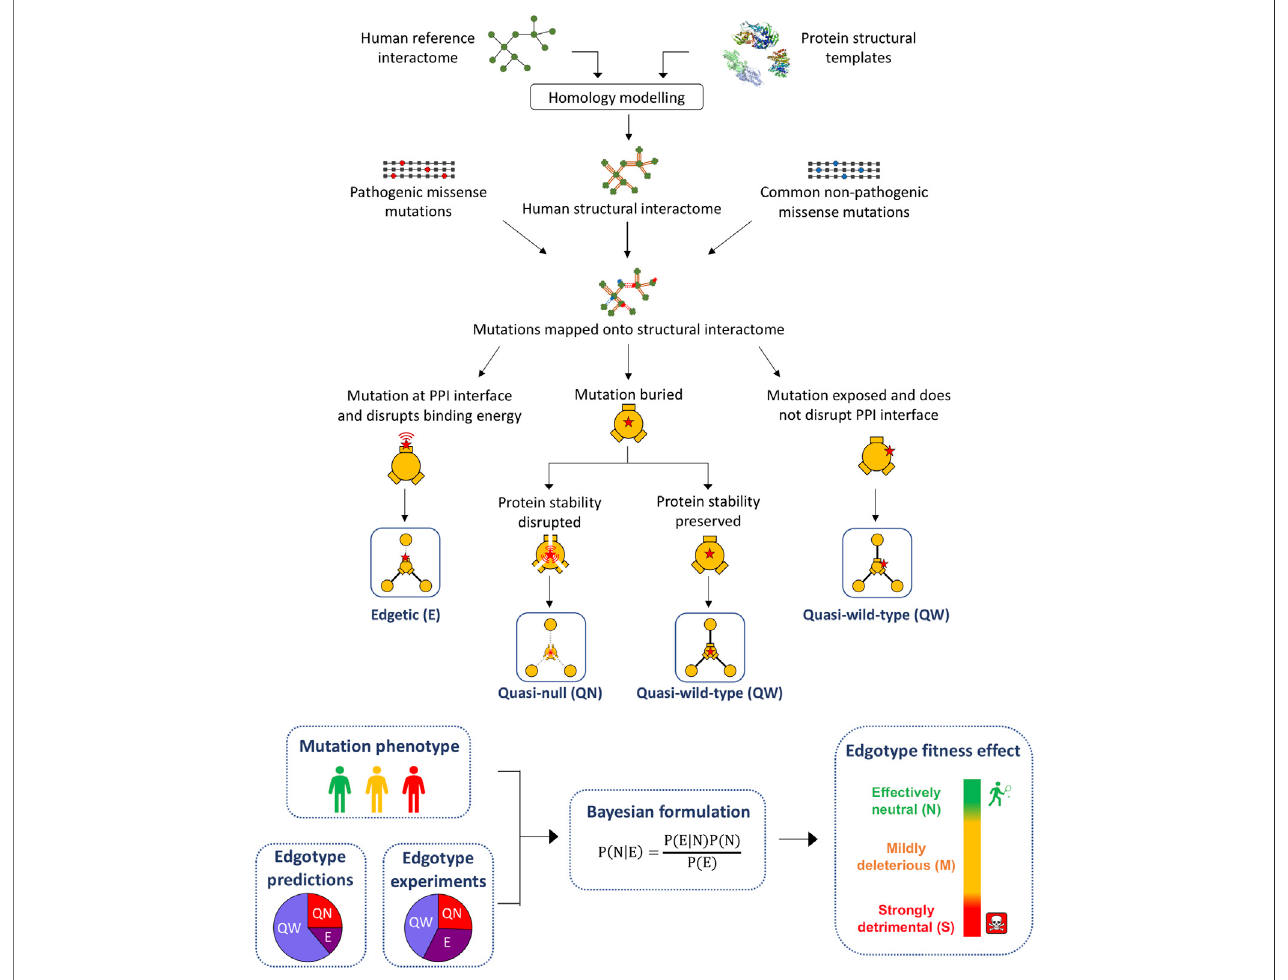
FIGURE1| Pipelineforthecomputationalpredictionofmutationedgotypes.Computationalpipelineusedfortheconstructionofthehumanstructuralinteractome, prediction of mutation edgotypes and calculation of edgotype fi tness